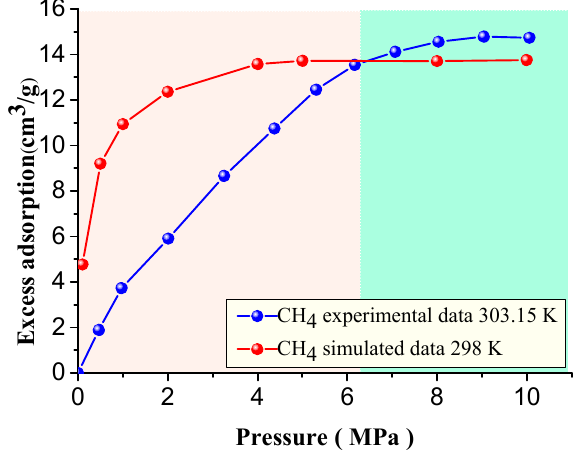
Figure 9. Comparison of the excess adsorption capacity of CH 4 at 298 K with the experimental data at 303.15 K.